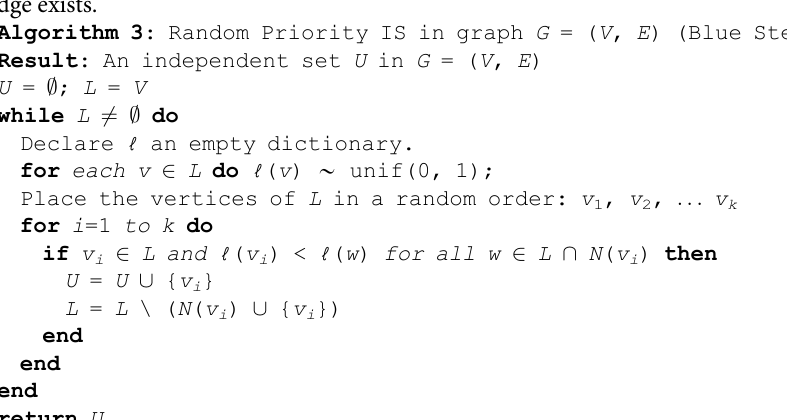
Algorithm 3 : Random Priority IS in graph G = ( V , E ) (Blue Step 2)